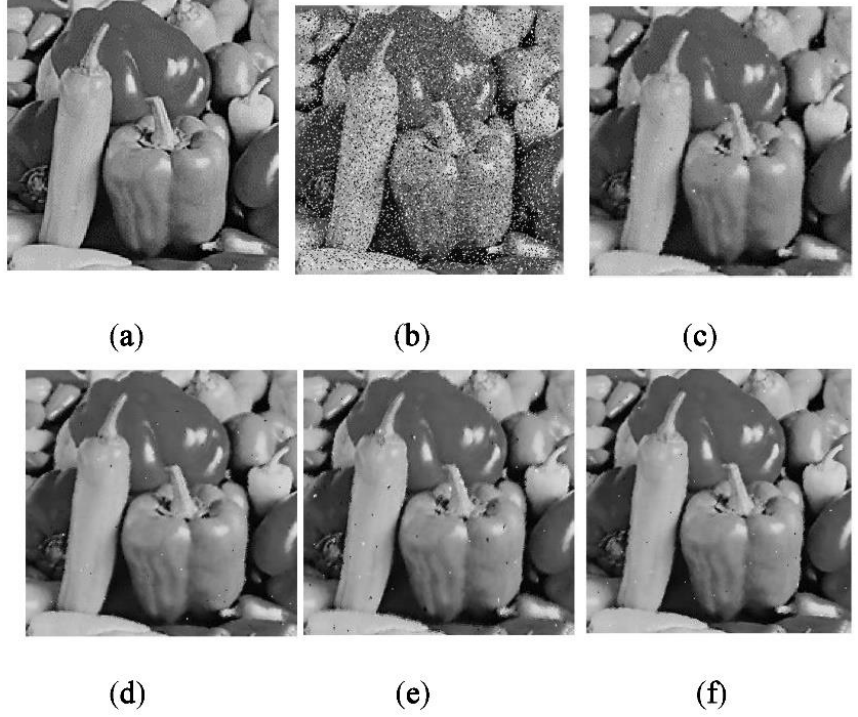
Figure 4. Impulsive Noise-Restored images with 20% density Using the TASOM classifier: ( a ) Original image; ( b ) Noisy image; ( c ) Mean; ( d ) Alpha Trimmed; ( e ) Pseudo Median; ( f ) Median.